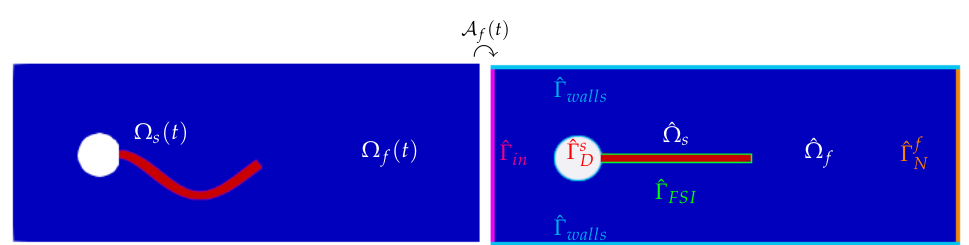
Figure 1. Fluid–structure interaction domains. Time-dependent configuration ( left ): fluid domain Ω ( t ) (blue) and solid deformed domain Ω s ( t ) (red). Reference configuration ( right ): the inlet f boundary ˆ Γ in (magenta), the wall boundaries for the fluid ˆ Γ walls (light blue), and the Neumann (outlet) boundary ˆ Γ f (orange). The fluid arbitrary reference configuration ˆ Ω f is depicted in blue, N the solid reference configuration ˆ Ω s is depicted in red, and ˆ Γ s is the solid Dirichlet boundary. The D fluid–structure interface in the reference configuration ˆ Γ FSI is highlighted in